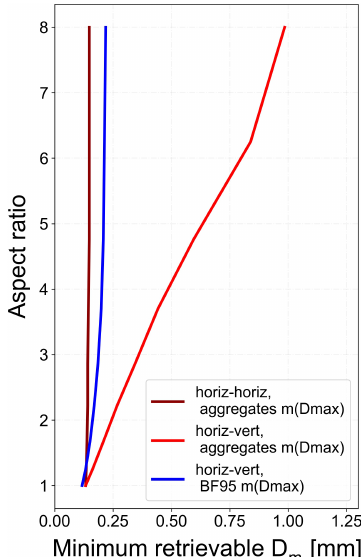
Figure C1. Minimum possible retrieved D m using ice spheroids following the m(D max ) of aggregates when the C-band and Ka- band beam are emitted horizontally (dark red). With red and blue, the minimum possible retrieved D m is plotted for ice spheroids following the m(D max ) of aggregates and BF95 when the C-band beam is emitted horizontally and the Ka band is emitted towards